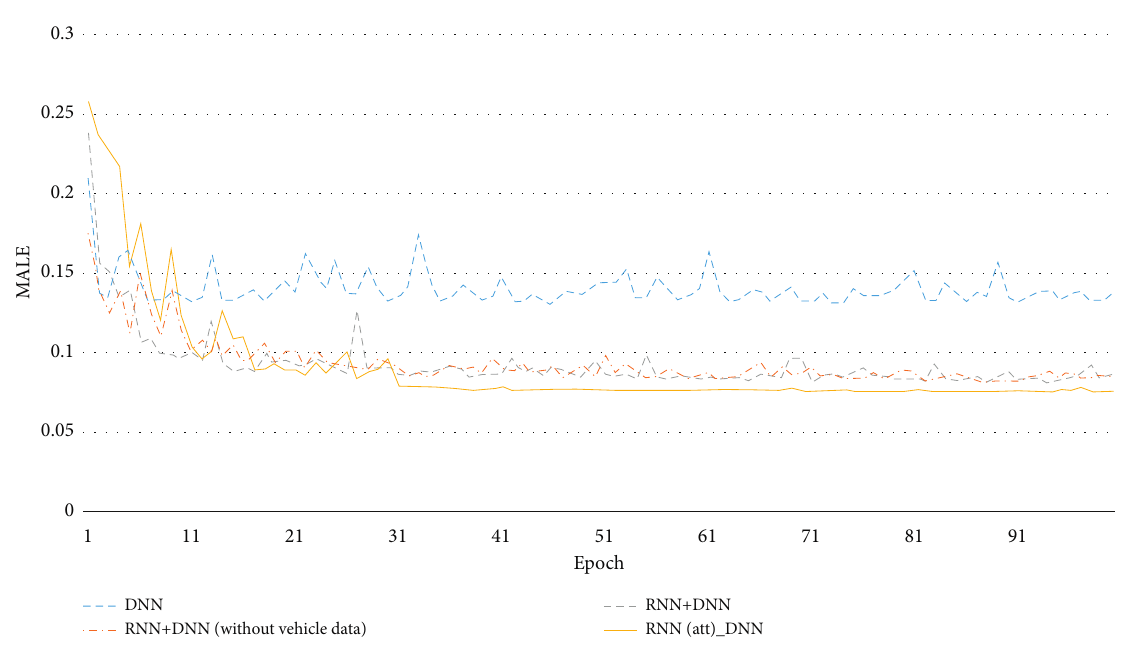
Figure 7: Training process of different